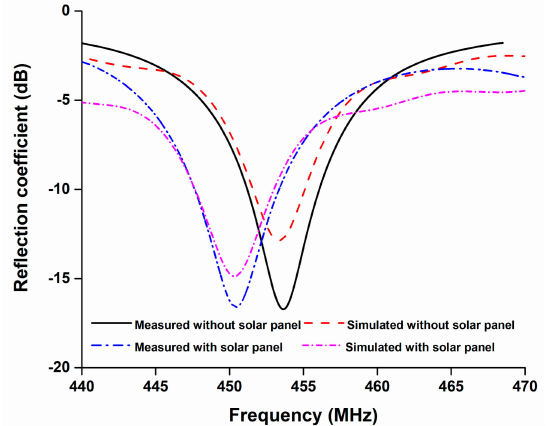
Figure 7. Simulated and measured reflection coefficient of the proposed antenna. Reflection coefficients are measured with and without the solar panel and the measured − 10 dB operating bandwidth is 447.5 MHz–453.5